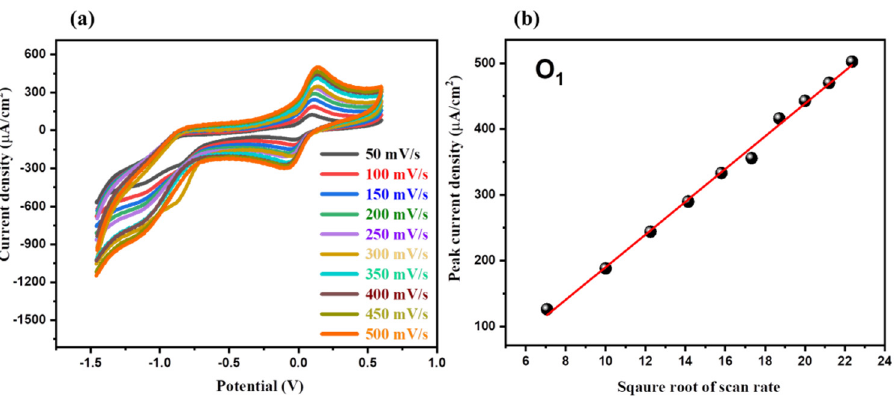
Figure 5. CV ( a ) of MnO 2 /rGO/GCE in 50 µM 4-NP (PBS = 0.1 M; pH = 7.0) at various scan rates (50–500 mV/s). Calibration plot ( b ) between the peak current and square root of various scan rates.